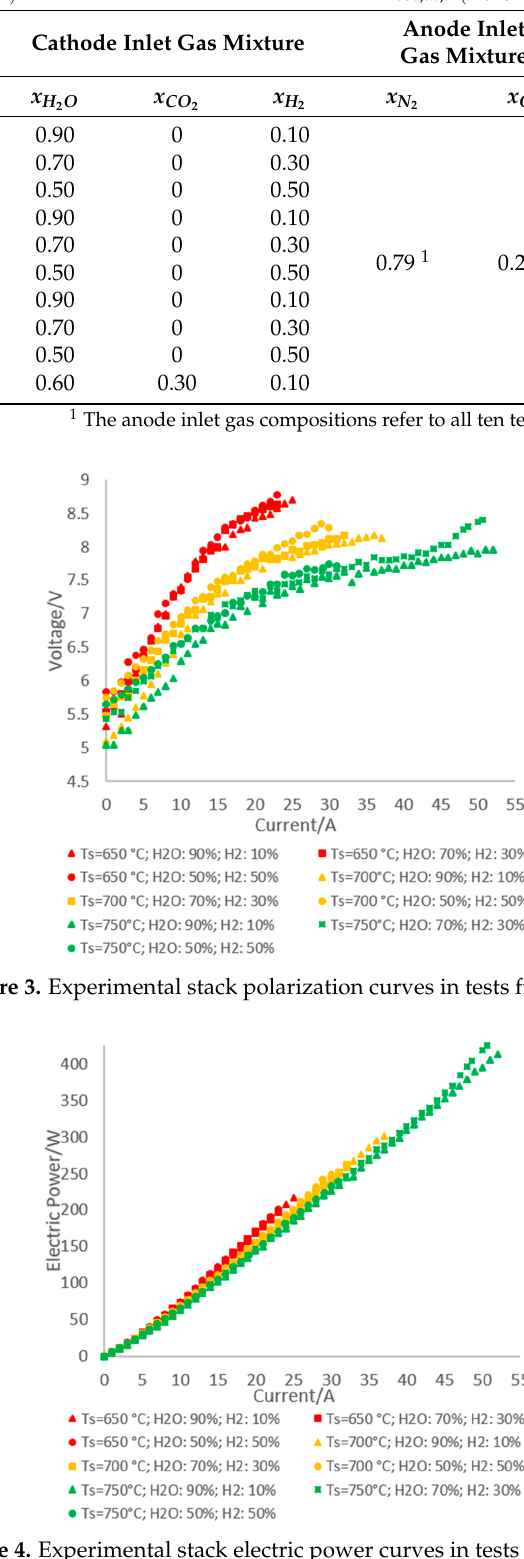
Table 2. Main parameters of experimental tests on SOE stack fed by steam, H 2 and/or CO 2 gas mixtures. F tot , in , ca ( mol · s − 1 )